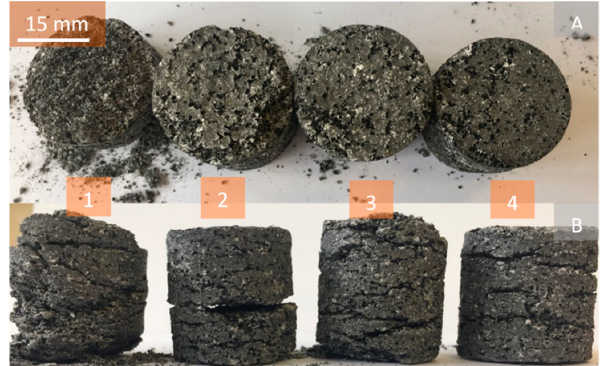
Figure 9. MSH/G+C (1:1) pellets after the 10th cyclic test shown as No.1, No.2, No.3, No.4 pellets with compression pressures of 1.3, 2.6, 3.9, 5.2 kN · mm -2 , respectively. ( A ) shows the top view, and ( B ) shows compression pressures of 1.3, 2.6, 3.9, 5.2 kN ⋅ mm -2 , respectively. ( A ) shows the top view, and ( B ) the side view of the shows the side view of the pellets.